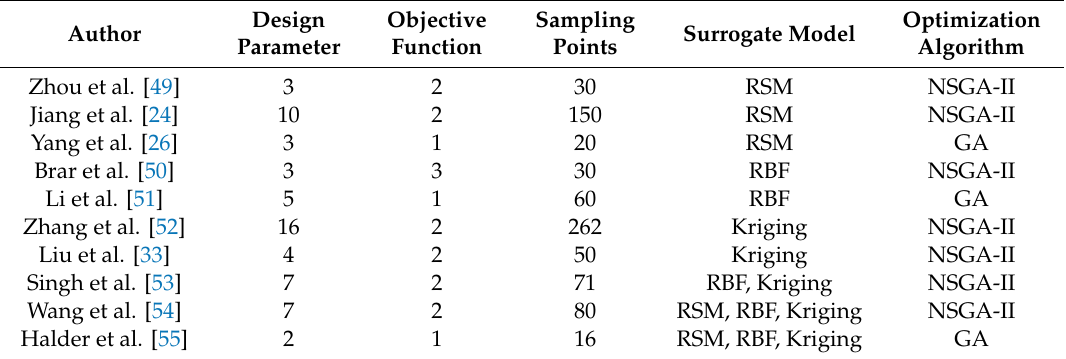
Table 3. A list of shape optimization investigated using surrogate models in recent